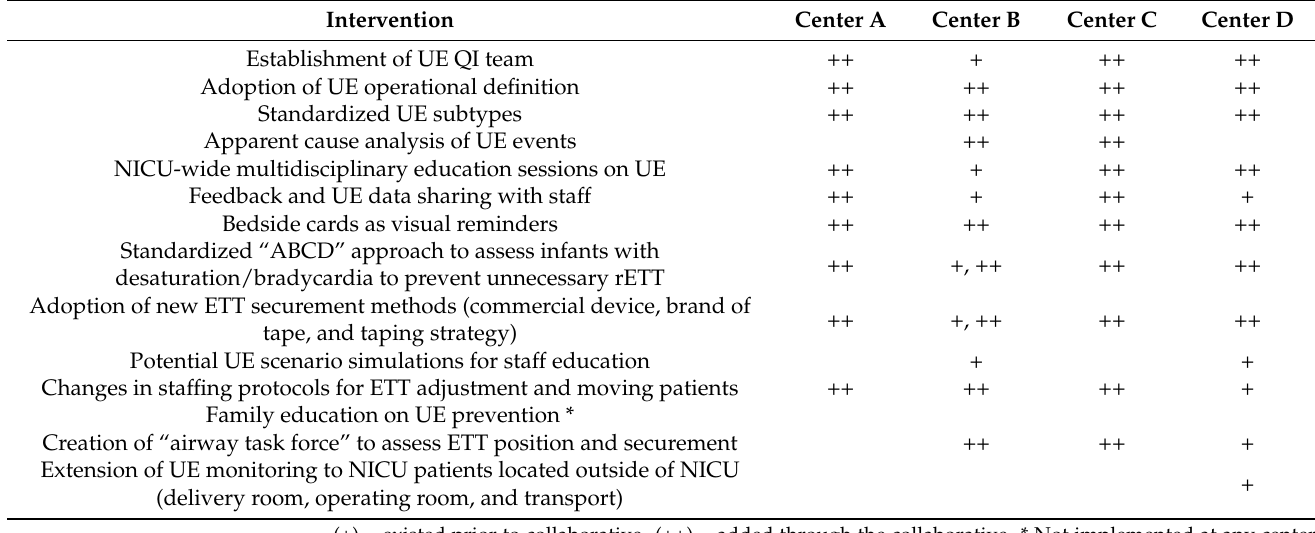
Figure 1. Example key driver diagram from Center D. Numbers under “Changes” indicate PDSA cycles. Table 1. UE prevention interventions adopted by individual centers.